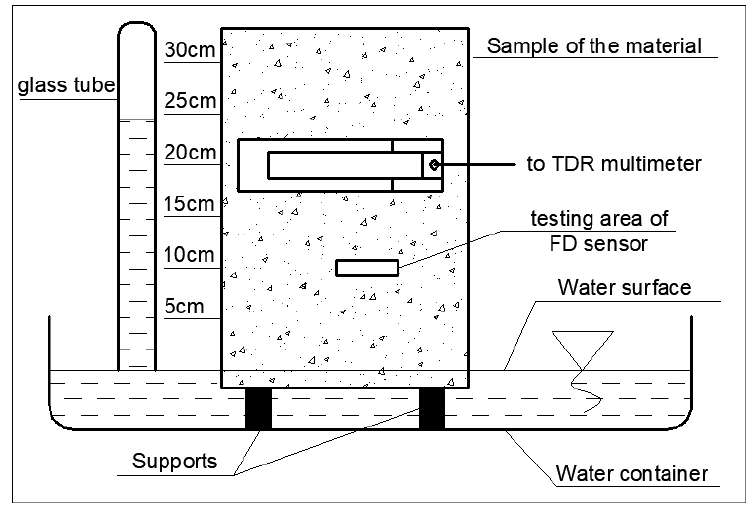
Figure 5. Schematic view of the capillary uptake setup.